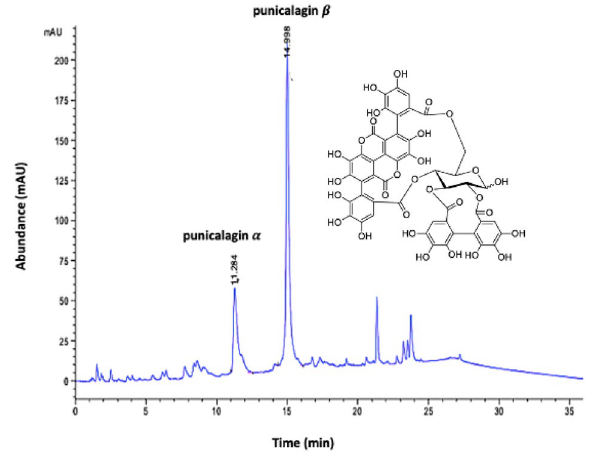
Figure 1. HPLC chromatogram of pomegranate rind extract (PRE) highlighting the major ellagitannin anomers α and β punicalagin; inset: the chemical structure of